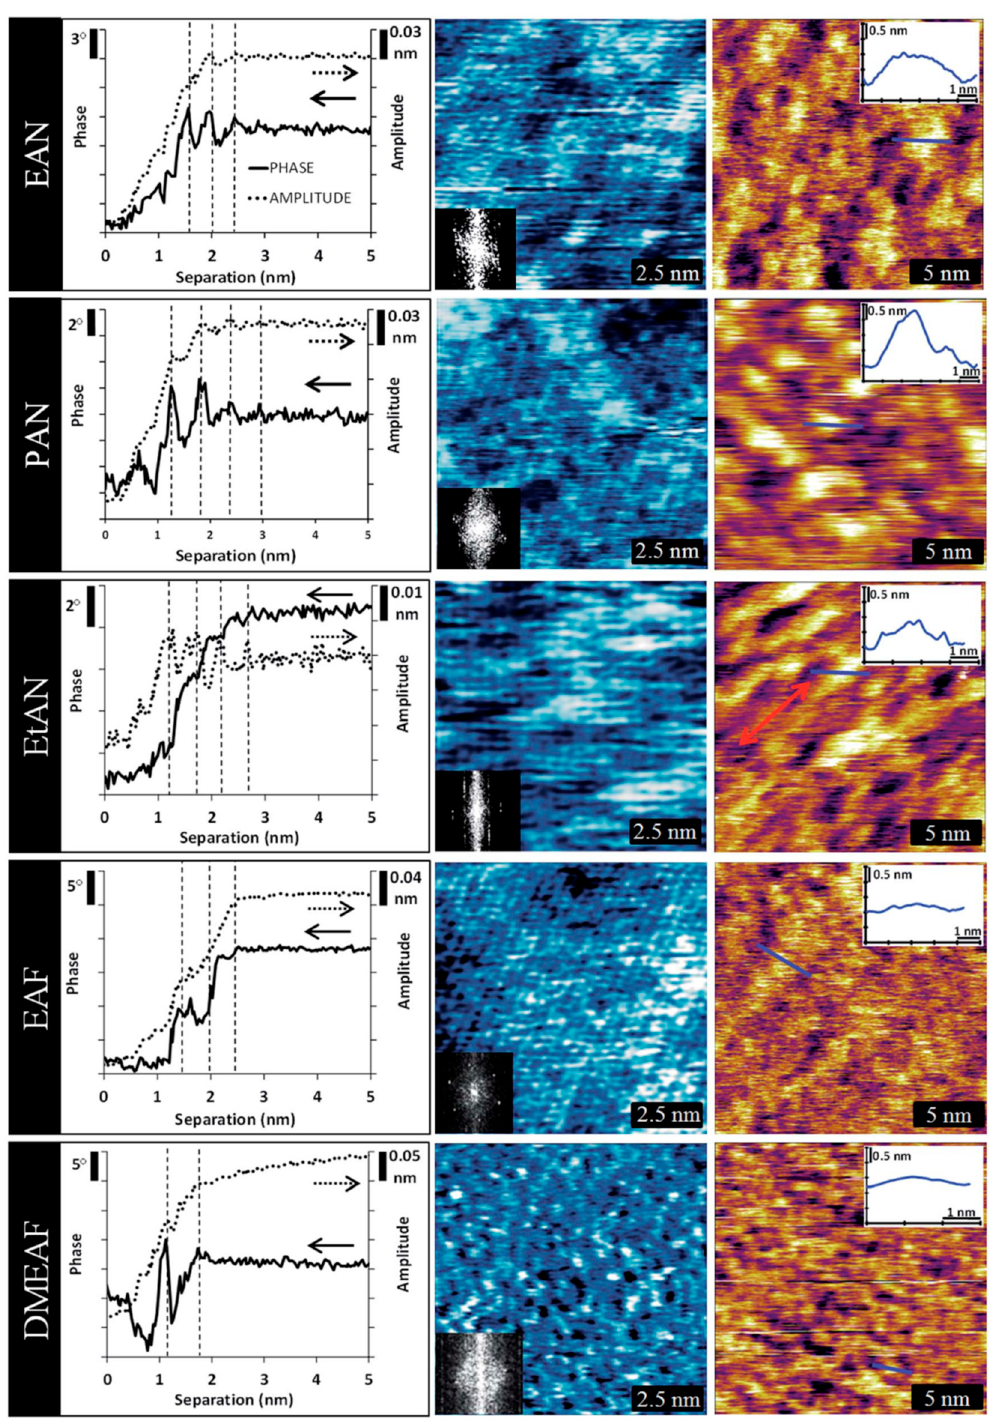
Figure 19. Amplitude modulation (AM)-AFM study of the interface between mica and di ff erent ionic liquids. Left: Amplitude and phase–separation curves. Right: Topographic images of the innermost (blue) and the first near-surface layer (brown). Adapted from Elbourne et al. [47]—Published by The Royal Society of